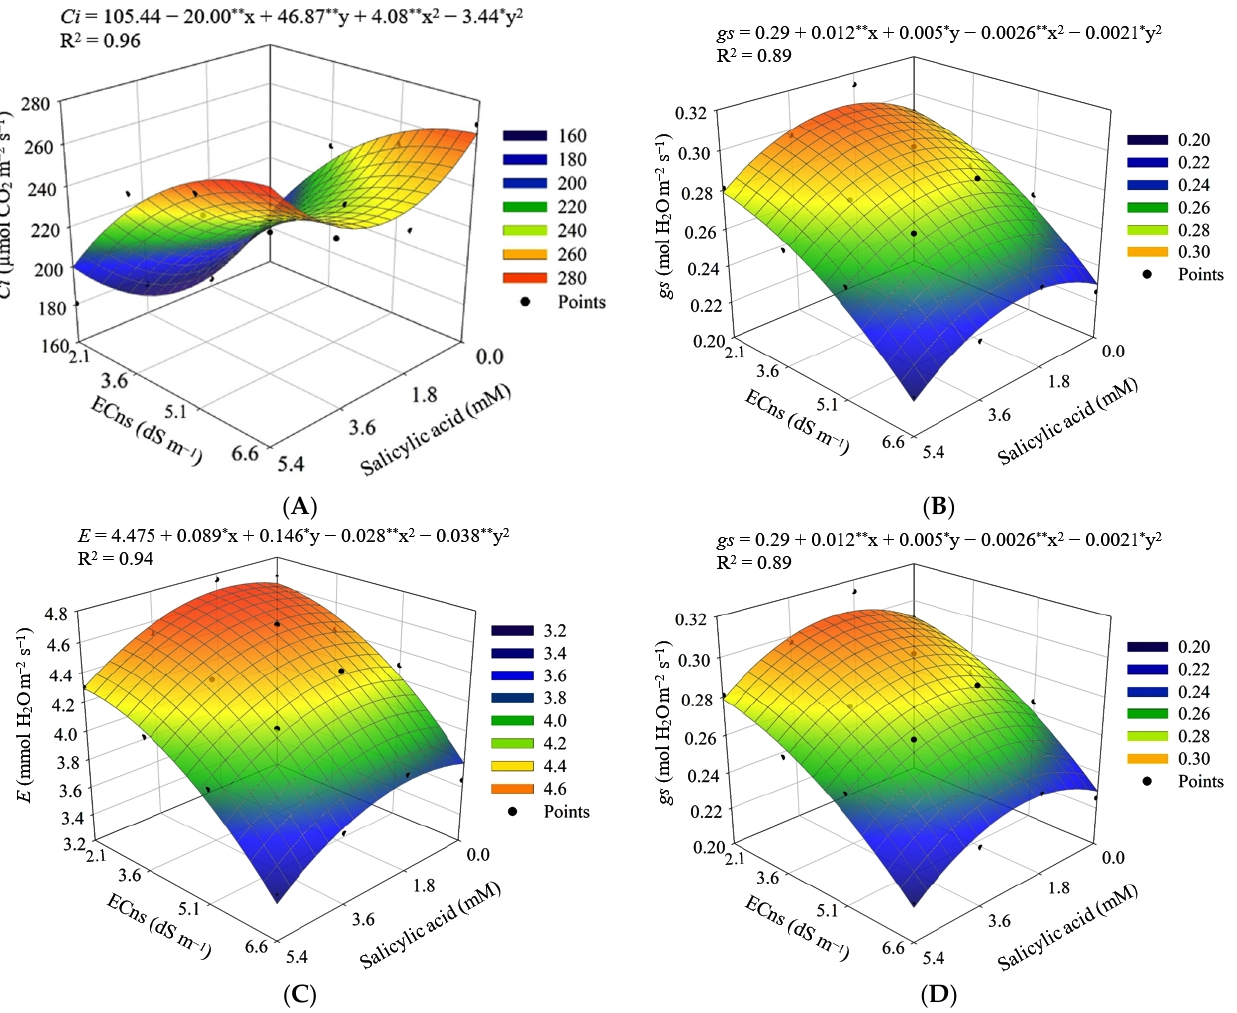
Figure 5. Response surface for internal CO 2 concentration— Ci ( A ), stomatal conductance— gs ( B ), transpiration— E ( C ), and CO 2 assimilation rate— A ( D ) of Japanese cucumber as a function of the interaction between the electrical conductivity of the nutrient solution (ECns) and the concentrations of salicylic acid (SA), grown in a hydroponic system, 40 days after transplanting. X and Y—concentration of SA and ECns, respectively; * and ** significant at a p ≤ 0.05 and p ≤ 0.01, respectively.